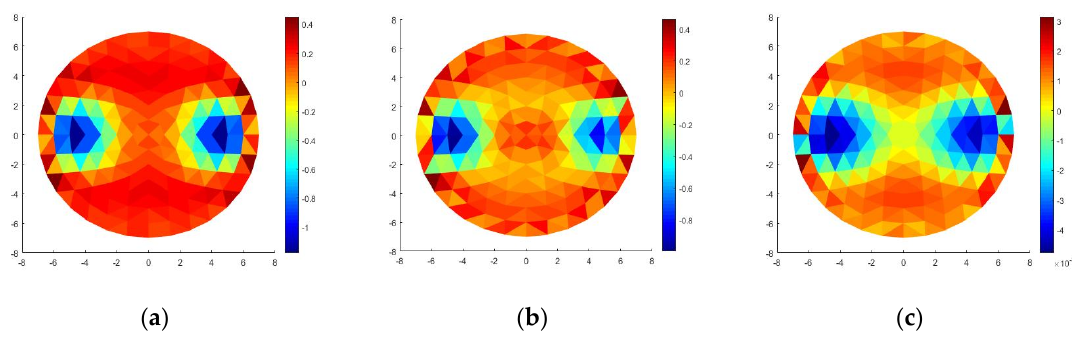
Figure 14. ( a ) Impedance image, ( b ) real image, ( c ) imaginary image.